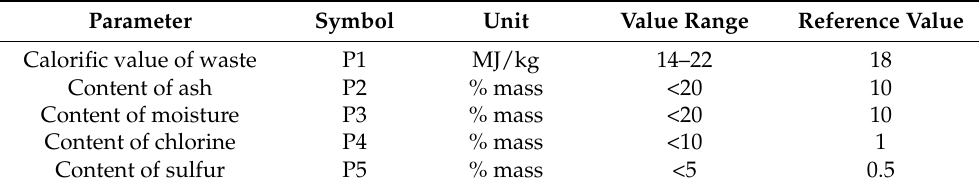
Table 1. Assumptions of the application parameters and their